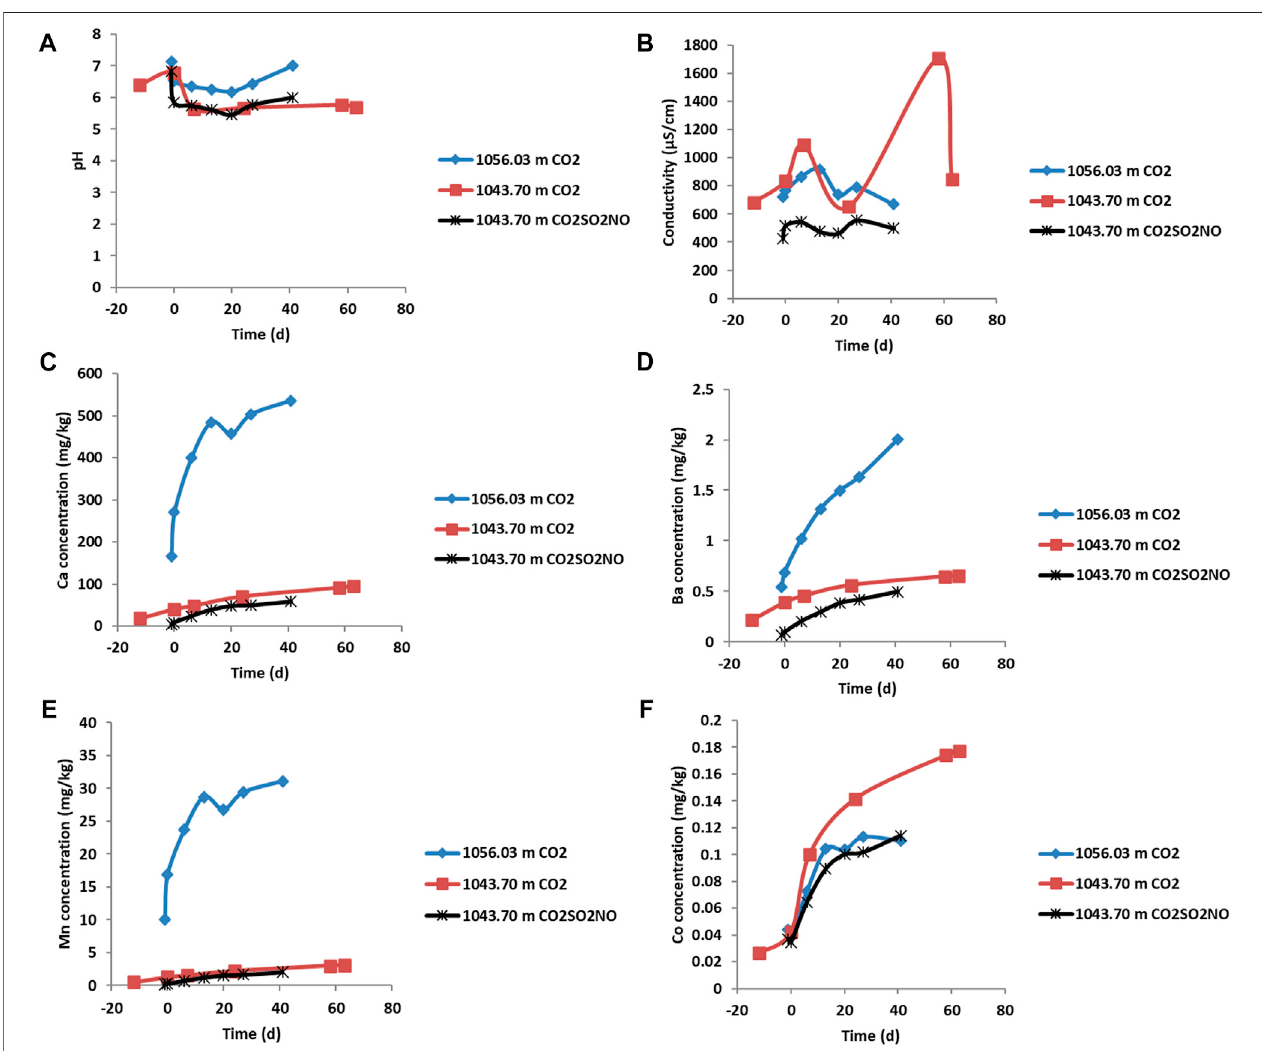
FIGURE 7 | Water quality parameters and dissolved element concentrations (mg/kg) during the reactions of Evergreen Formation core with CO 2 or CO 2 SO 2 NO. The negative time points represent the water composition and water rock interaction, and the CO 2 gas was introduced at time zero. (A) Solution pH, (B) electrical conductivity, (C) concentration of Ca, (D) Ba, (E) Mn, (F) Co. The concentrations have an error of 5% within the size of the symbols.